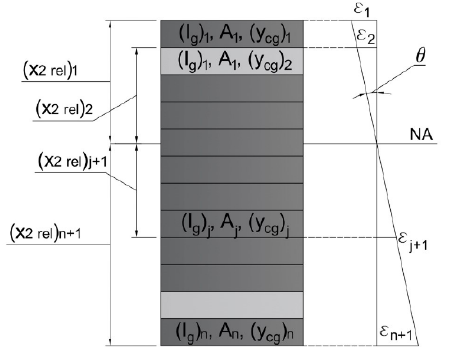
Figure 5. Layer properties and strain in each